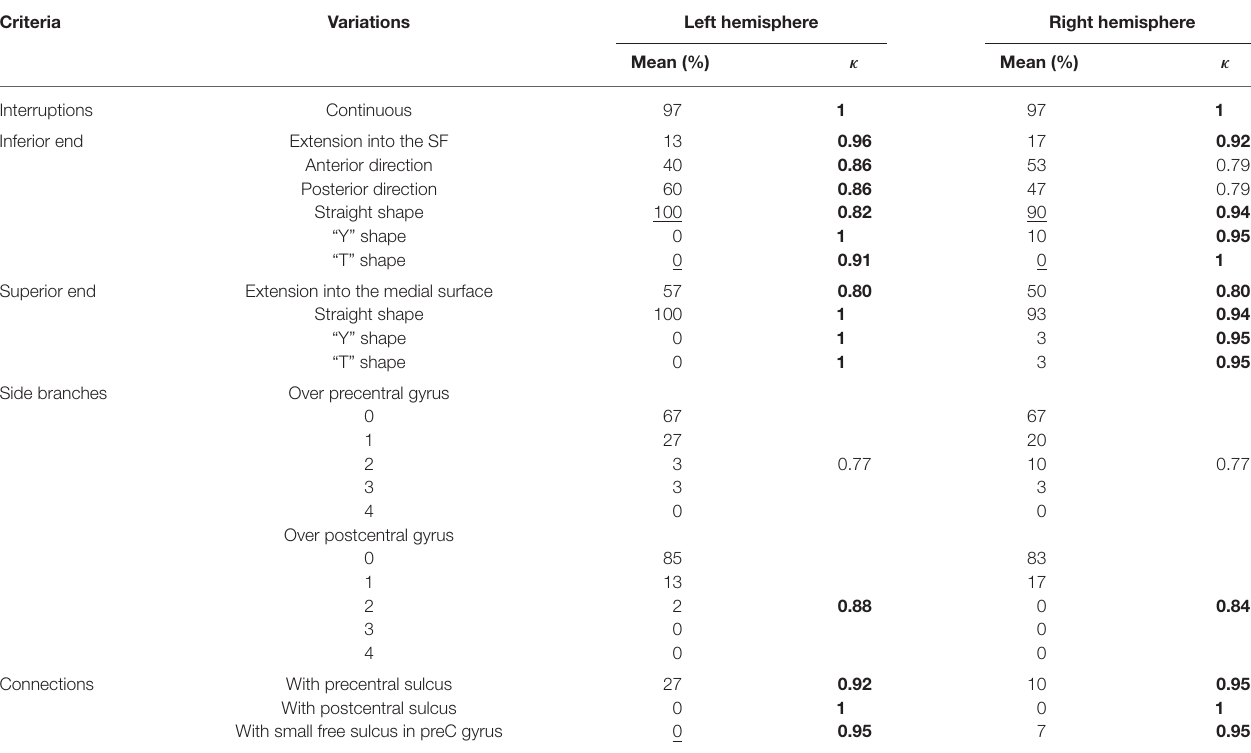
TABLE 4 | Mean occurrence frequency and inter-rater concordance of each criterion of the CS in the left and right